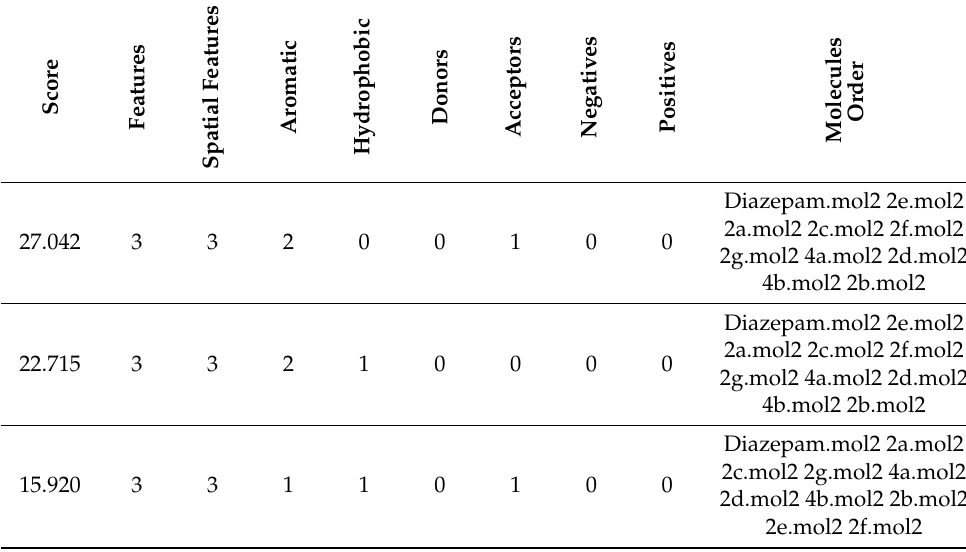
Table 2. Putative Pharmacophore Groups Outcomes, for